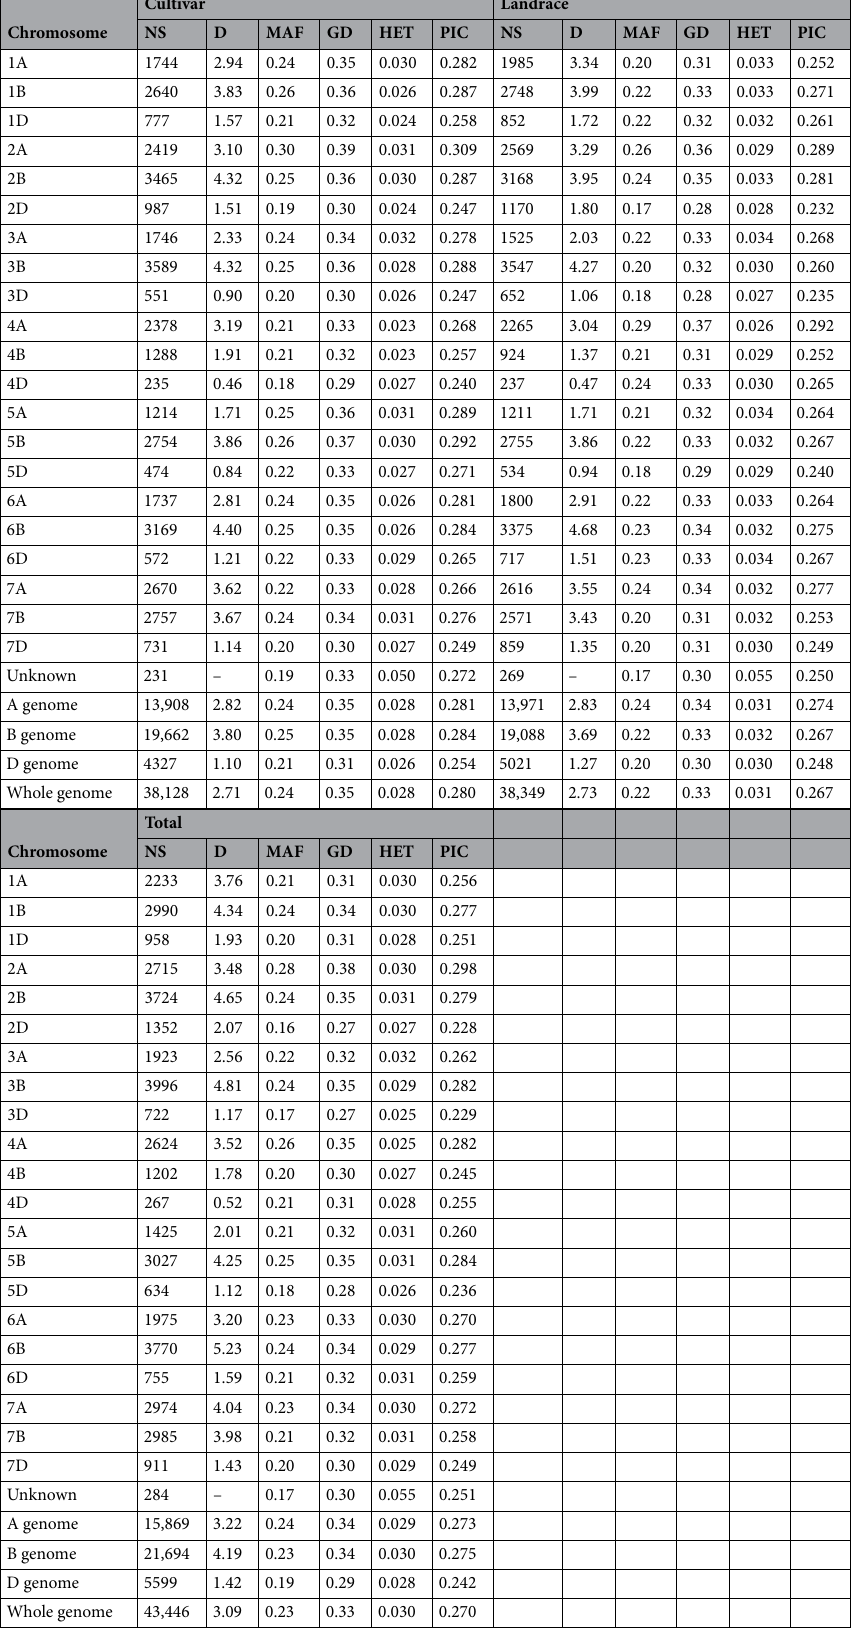
Table 2. Distribution of SNP markers and indices of genetic diversity by chromosomes. NS number of SNPs, D density (SNP/Mbp), MAF minor allele frequency, GD gene diversity, HET heterozygosity, PIC polymorphism information